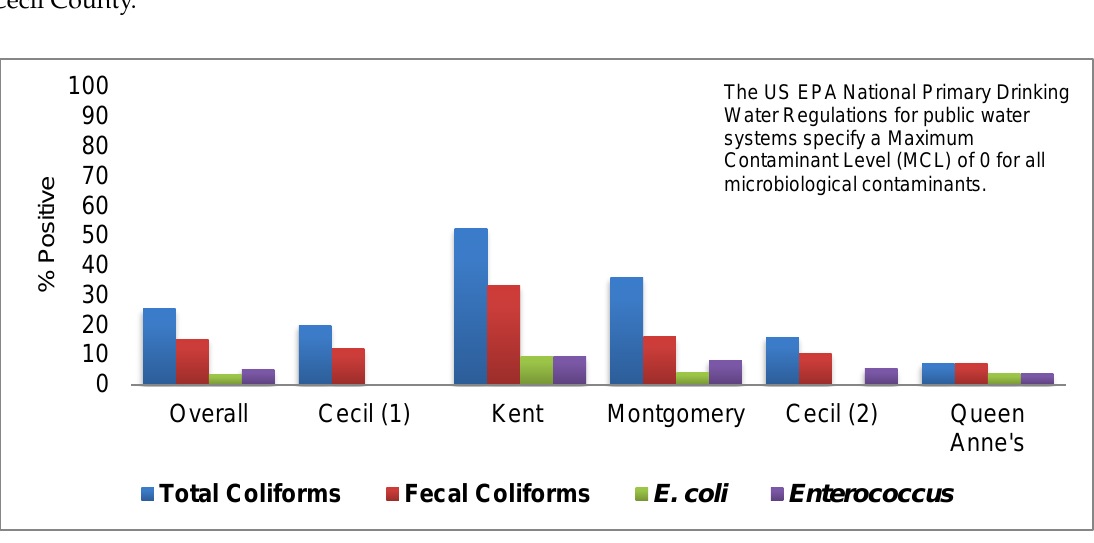
Figure 5 . Percentage of tested private wells that were positive for fecal indicator bacteria by county.